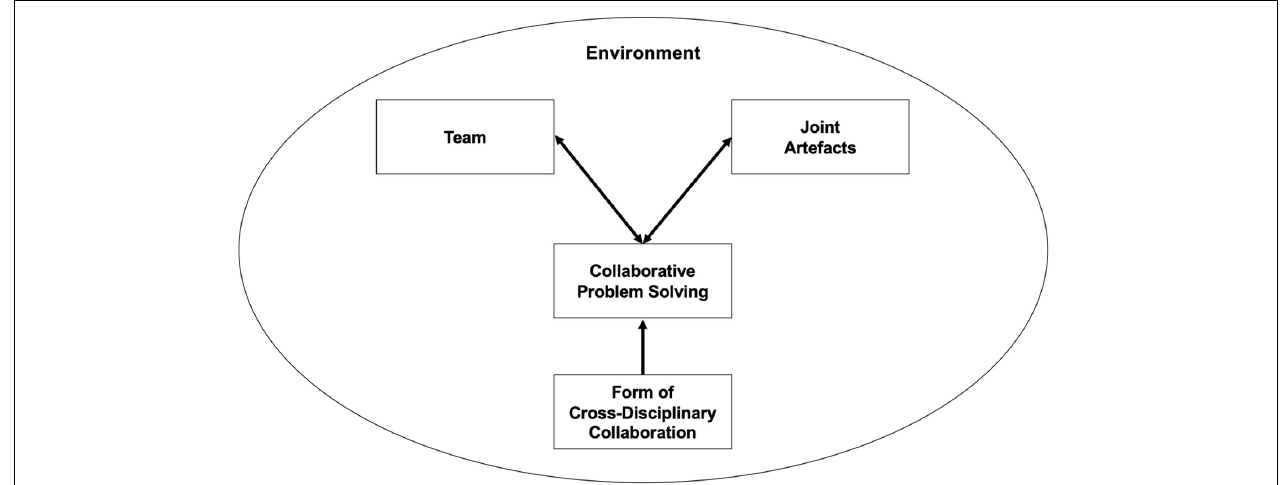
FIGURE 1 | Conceptualization of cross-disciplinary research in learning and